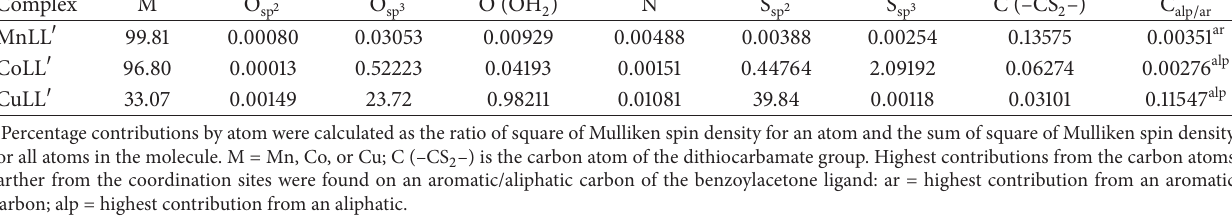
Table 1: ∗ Atomic percentage contributions to the spin density delocalization derived from the Mulliken atomic spin density values. Complex M